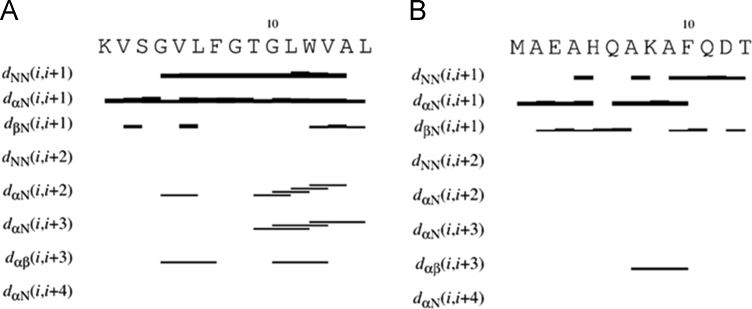
Relevant NOE contacts in TFE:H2O 1:1 for (A) MTP1 and (B) MTP2.